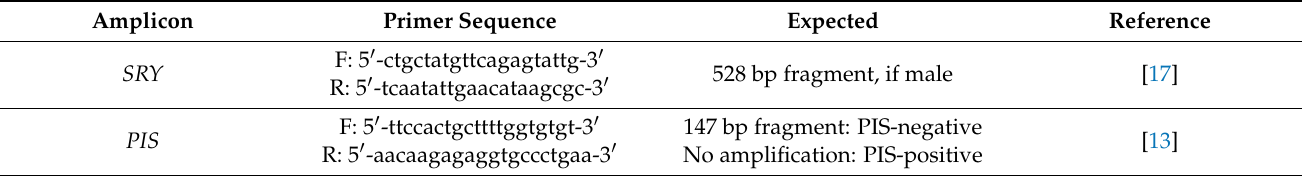
Table 1. Sequences of primers used in the PCRs with expected